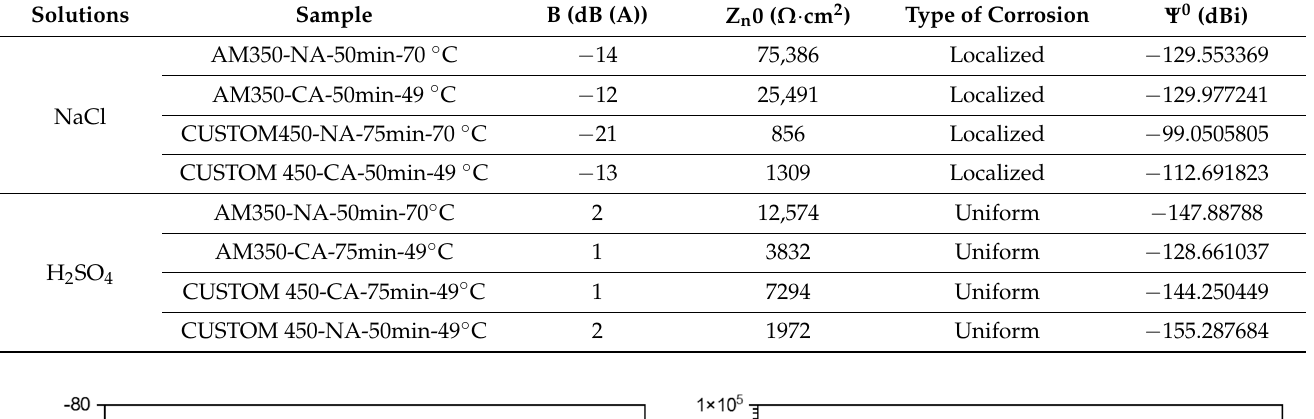
Figure 4. ( a ) Power spectral density (PSD) and ( b ) noise impedance (Z n ) for CUSTOM 450 and AM 350 passivated stainless steels immersed in 1 wt. % H 2 SO 4 solution.